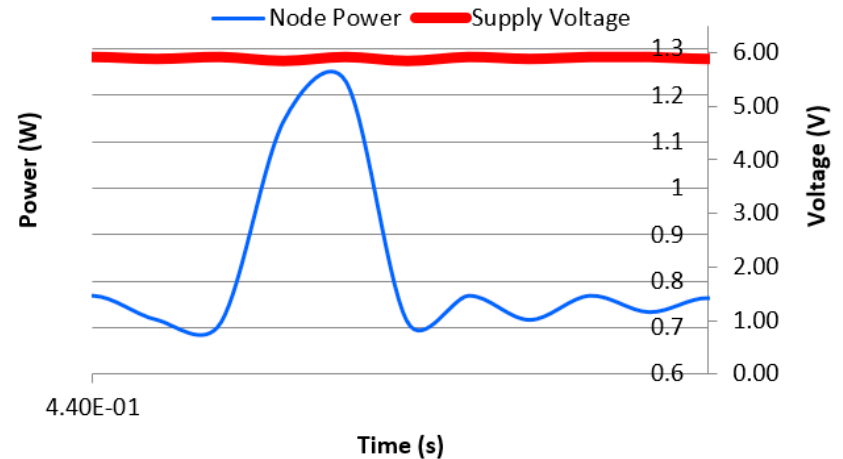
Figure 13. Zoomed-in view of the power consumption from Figure 12.